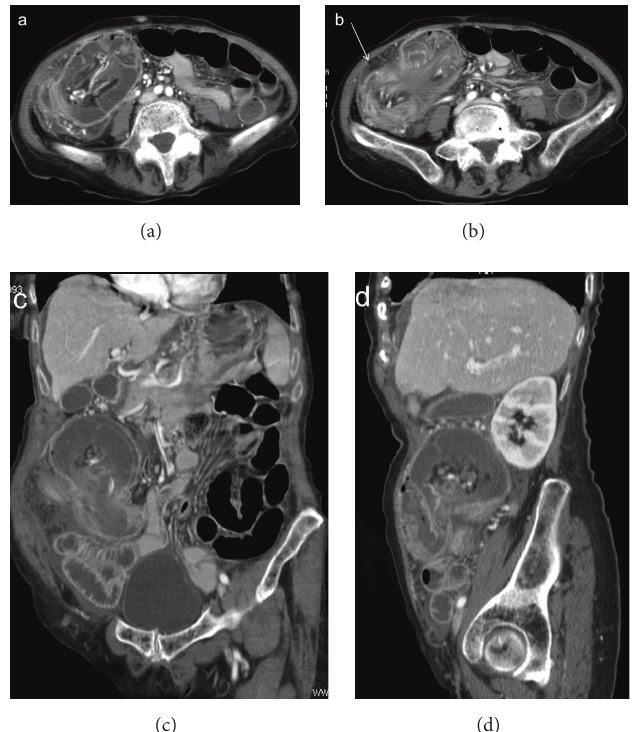
Figure 4: Enterocolic (ileocaecocolonic) intussusception due to a caecal carcinoma. CT images on axial scans (a, b) and oblique reformatting (c, d) show lymph nodes and vascular engorgement in the intussuscepted mesentery and fluid distention of the intussuscipiens. Extraparietal air indicates local perforation (arrow).